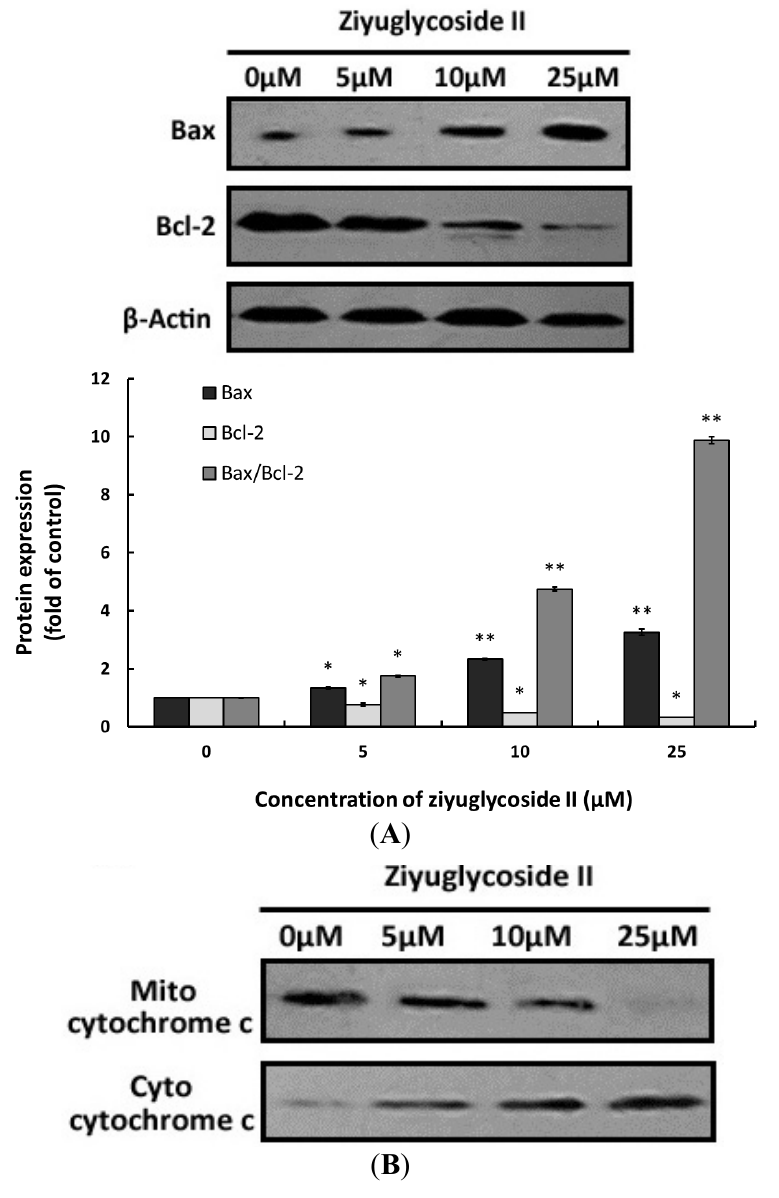
Figure 6. The effect of ziyuglycoside II on expressions of apoptosis related proteins. Cells were incubated with various concentrations of ziyuglycoside II for 24 h and then the expressions of Bax, Bcl-2 and cytochrome c were assessed by western blot analysis. ( A ) Protein expression of Bax and Bcl-2: Upper panel : immunobloting of Bax and Bcl-2, while β -actin was probed as the protein loading control; Lower panel : densitometry analysis of Bax, Bcl-2 and Bax/Bcl-2 ratio. All data were expressed as mean ± SD of three experiments and each experiment included triplicate repeats. * p < 0.05, ** p < 0.01 vs. control; ( B ) Immunobloting of mito-cytochrome c and cyto-cytochrome c. All data were representative of three independent